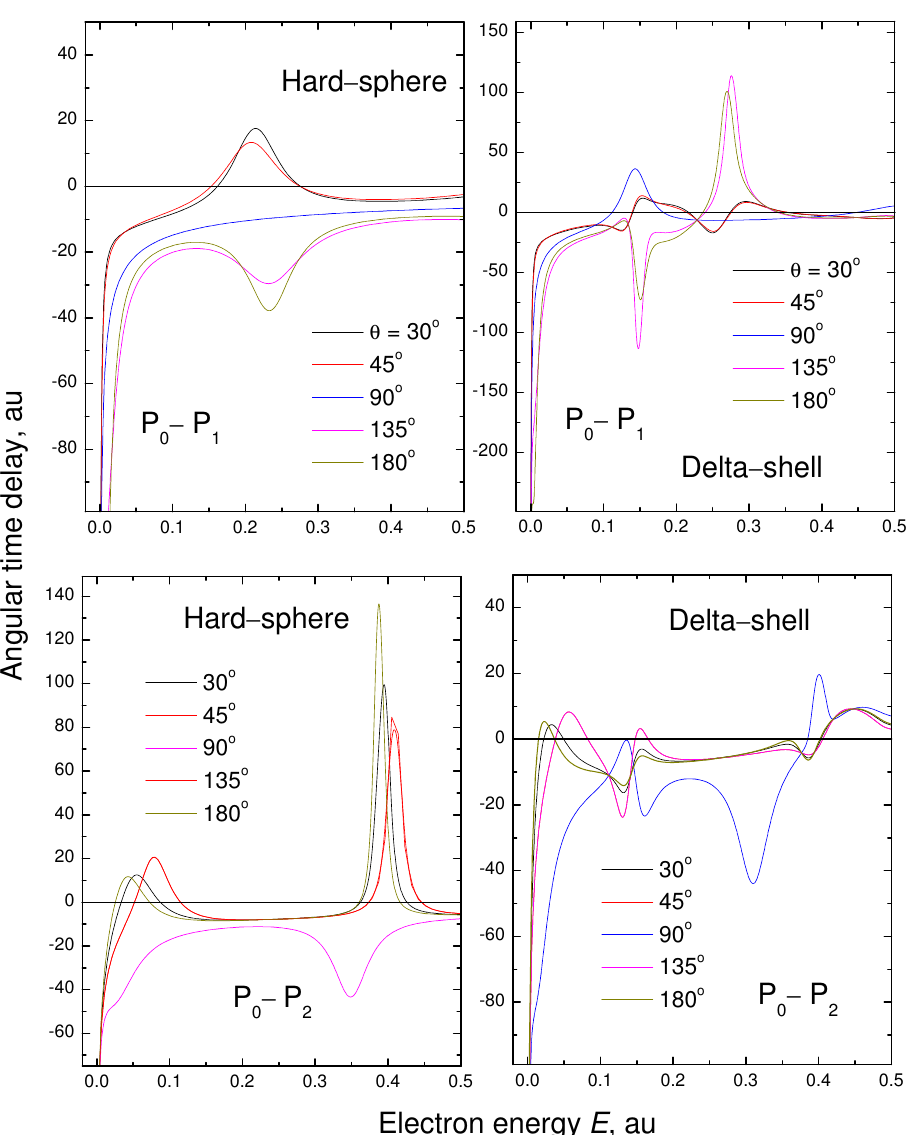
Figure 3. The angular time delay ∆ t ( k , θ ) as a function of the electron energy E for some fixed values of the polar angle θ . P 0 ( cos θ ) - P 1 ( cos θ ) is the pair of Legendre polynomials in the upper panels. P 0 ( cos θ ) and P 2 ( cos θ ) are the polynomials used in both lower panels. All curves in this figure tend to infinity at small electron momenta. The reason for this is that the scattering phase shift in short-range potentials must follow the Wigner threshold law δ l ( E ) ∝ E l + 1/2 [30]. In the case of s -phase shift, we have δ 0 ( E → 0 ) ∝ π − E 1/2 . The time delay ∆ t ( k , θ ) 01 and ∆ t ( k , θ ) 02 , that contain the derivative of the s -phase shift, for ( E → 0 ) ∝ − E − 1/2 . For the orbital moments l > 0 the derivative k → 0 tends to infinity: δ (cid:48) 0 ( E → 0 ) ∝ − E l − 1/2 . of the phase shifts does vanish at the threshold as δ (cid:48) 0 The left column of the figures corresponds to the electron scattering by the hard- sphere potential. The figures in the right column correspond to scattering by the delta-shell potential. In the upper right panel of Figure 3, the curves practically coincide with